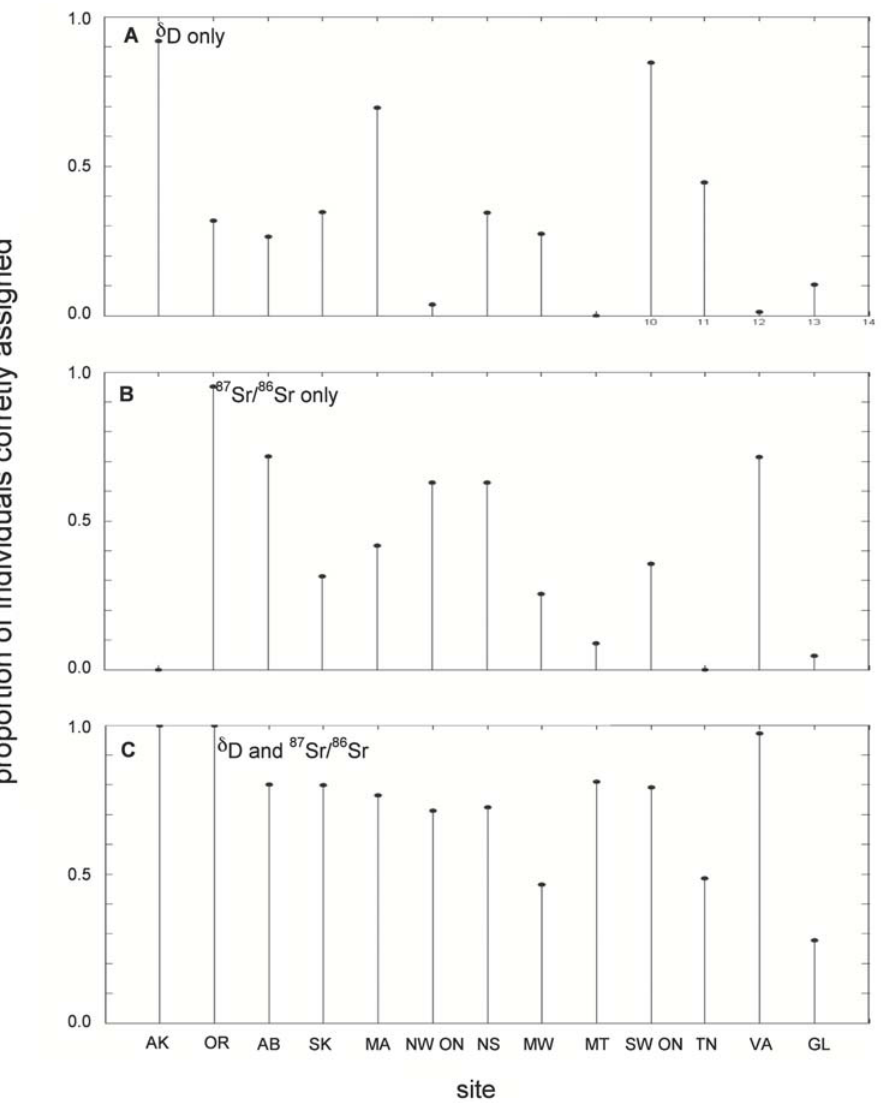
Figure 7. The proportion of Tree swallows correctly assigned to their original site of origin. Same as figure 6, except 18 sites were collapsed to 13 sites based on geographic proximity. The Great Lakes group (GL) includes Ithaca, NY, Elgin, ON, Allendale, MI, and Saukville, WI, the Mid-west group (MW) includes Ames, IA, Big Horn, WY, and Brandon, MB. All other sites are the same as in figure 6.